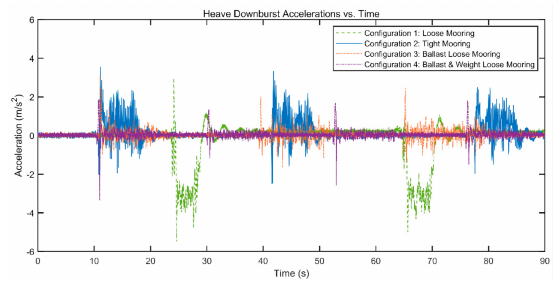
Figure A7. Downburst heave accelerations for all configurations.